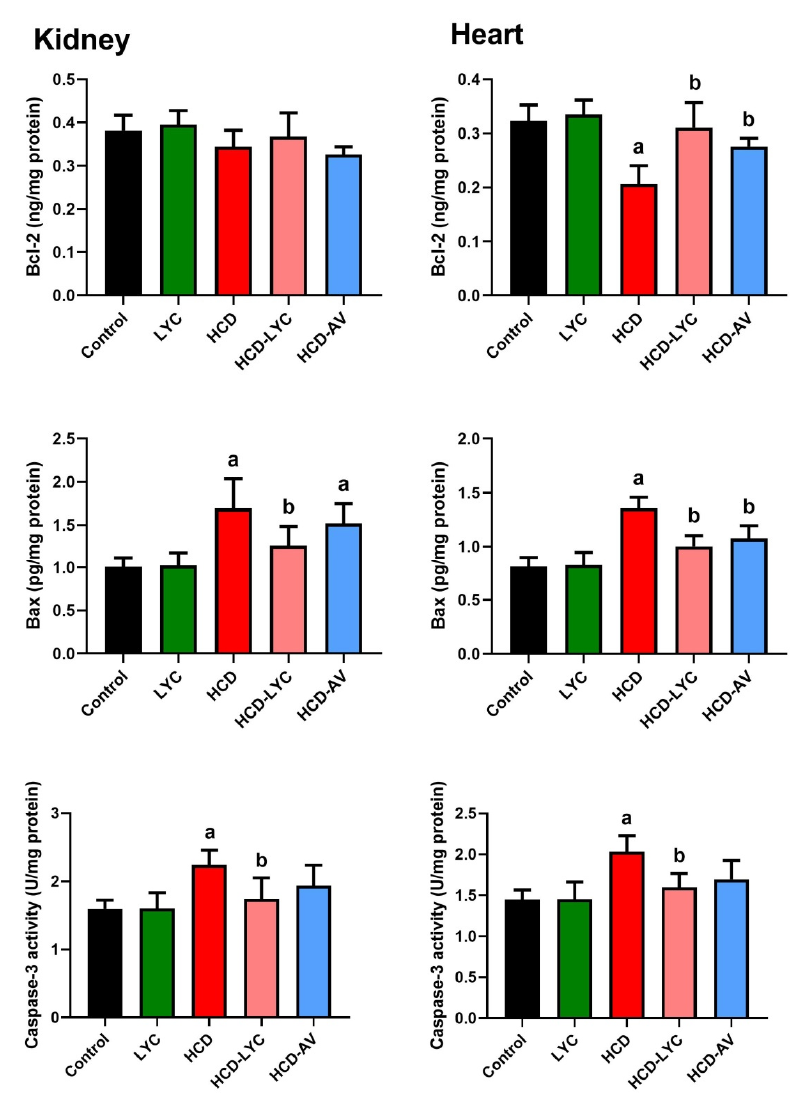
Figure 6. Effects of dietary cholesterol and lycopene on cardiac and renal B-cell lymphoma 2 (Bcl-2), BCL2 associated X, apoptosis regulator (Bax), and caspase-3 levels in rats over 12 weeks. Letters a and b indicate statistically significant differences between control and HCD groups, respectively, at p < 0.05.